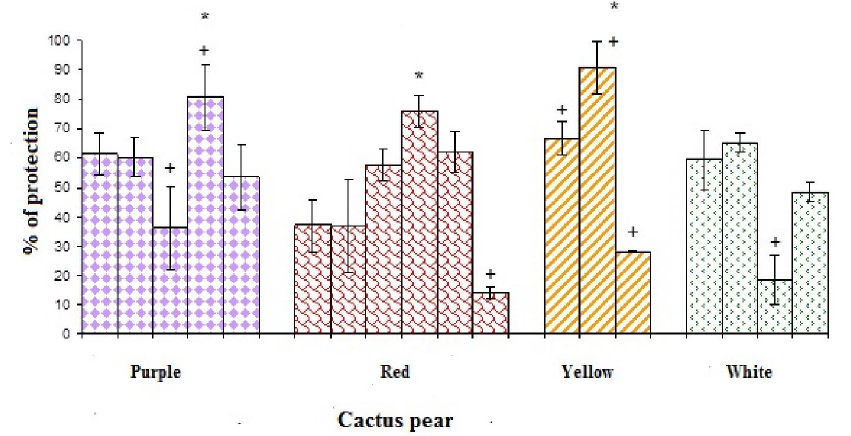
Figure 6. Antioxidant activity by the β-carotene and linoleic acid method of cactus pear studied cultivars. * denotes statistical significance at p < 0.05 among all studied cultivars of cactus pears. + indicates statistical significance at p < 0.05 among the cultivars of cactus pears in the same